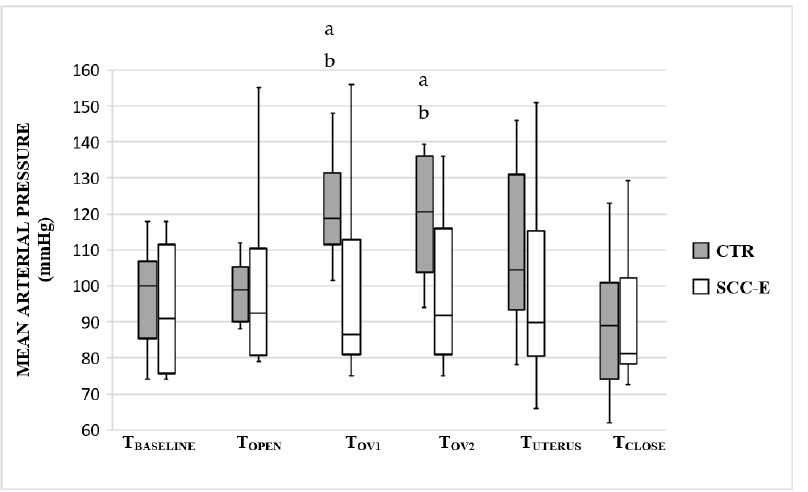
Figure 2. Systolic arterial pressure (SAP) in cats undergoing ovariohysterectomy with (SCC-E group) or without (CTR group) sacrococcygeal epidural ( n = 10 in each group). Times: T BASELINE , prior to skin incision; T OPEN , abdominal skin incision; T OV1 , from traction to removal of left ovary; T OV2 , from traction to removal of right ovary; T UTERUS , traction and ligation of the uterus; T CLOSE , during celiorraphy until the end of surgery. The horizontal line inside the boxes denotes the median value, while the upper and lower whisker bounds denote the maximum and minimum values. The boxes show the interquartile ranges. a Significant difference compared with T BASELINE ( p -values were 0.009 and 0.006 for T OV1 and T OV2 , respectively). b Significant difference compared with the SCC-E group ( p -values were 0.040 and 0.037 for T OV1 and T OV2 , respectively).